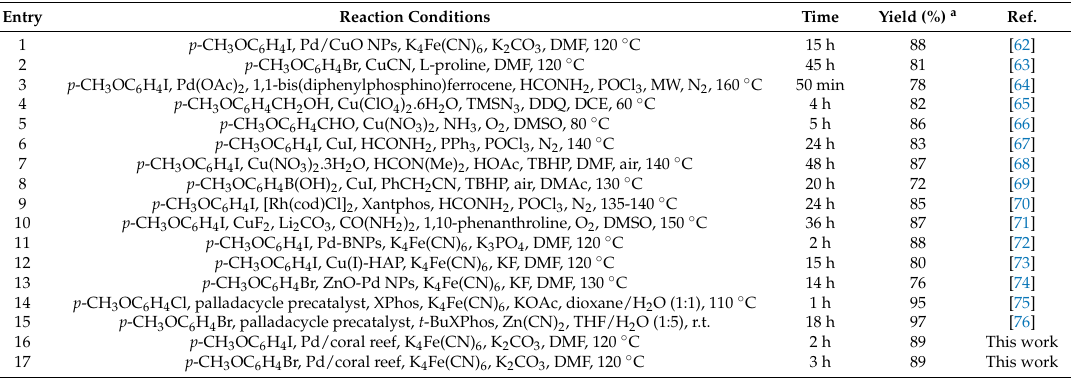
Table 3. Comparison of the Pd/coral reef nanocomposite with other previously reported catalysts in the synthesis of 4-methoxybenzonitrile.